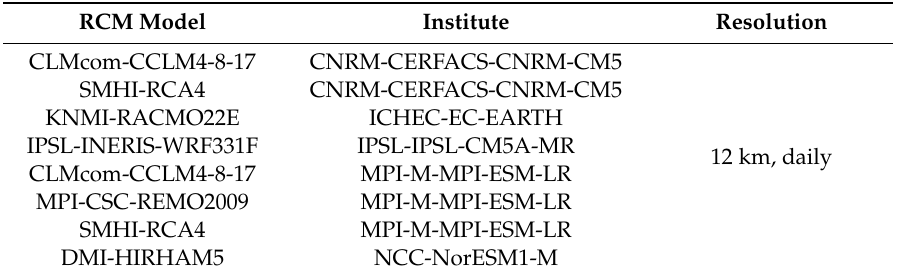
Table 1. Description of the eight regional climate models that are used for the projections of the hydrological modeling.